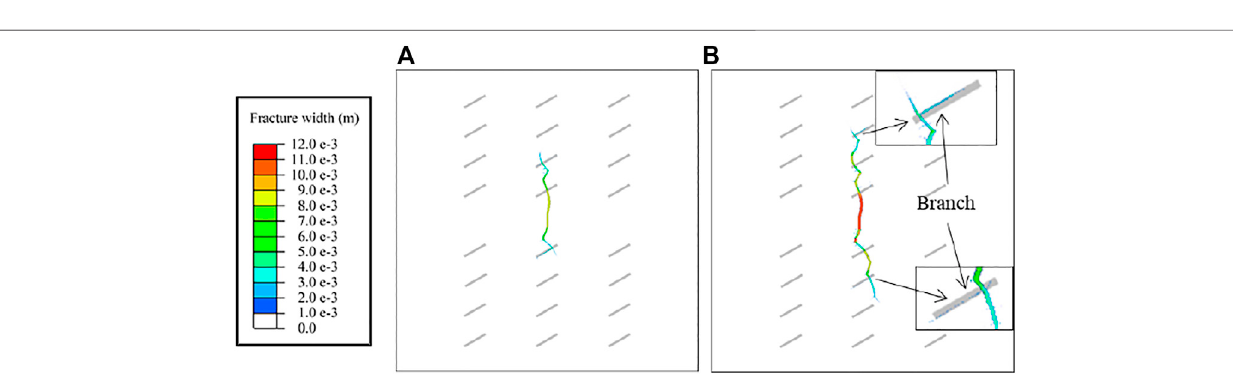
Frontiers in Earth Science |